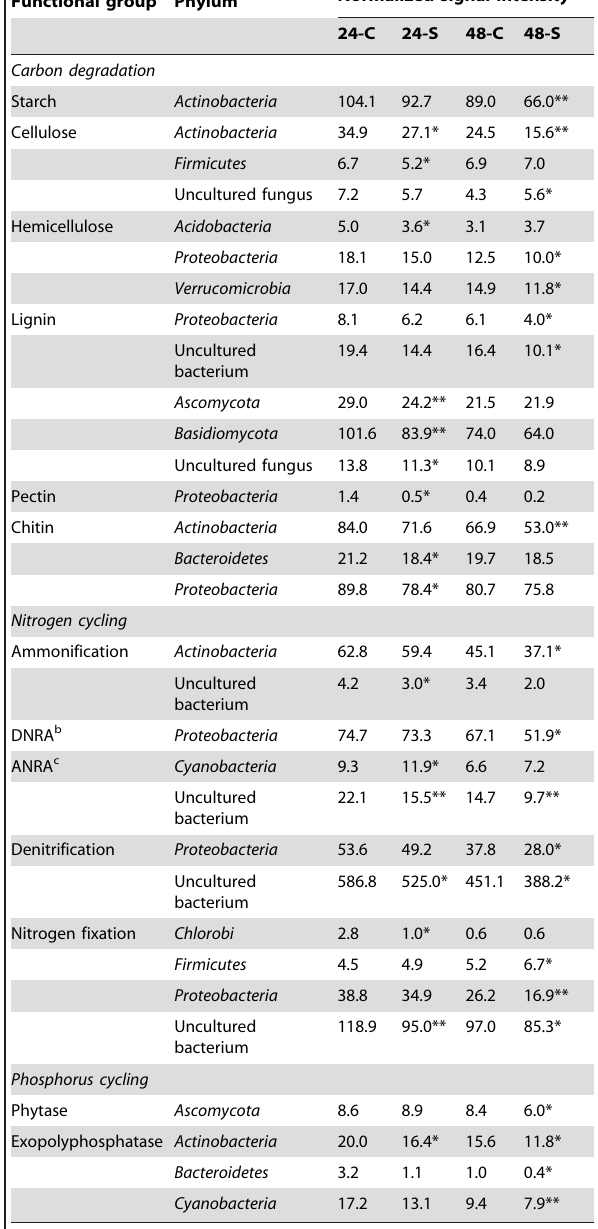
Table 3. Phylogenetic origins of carbon, nitrogen, and phosphorus cycling genes affected significantly by the presence of EcO157 in the